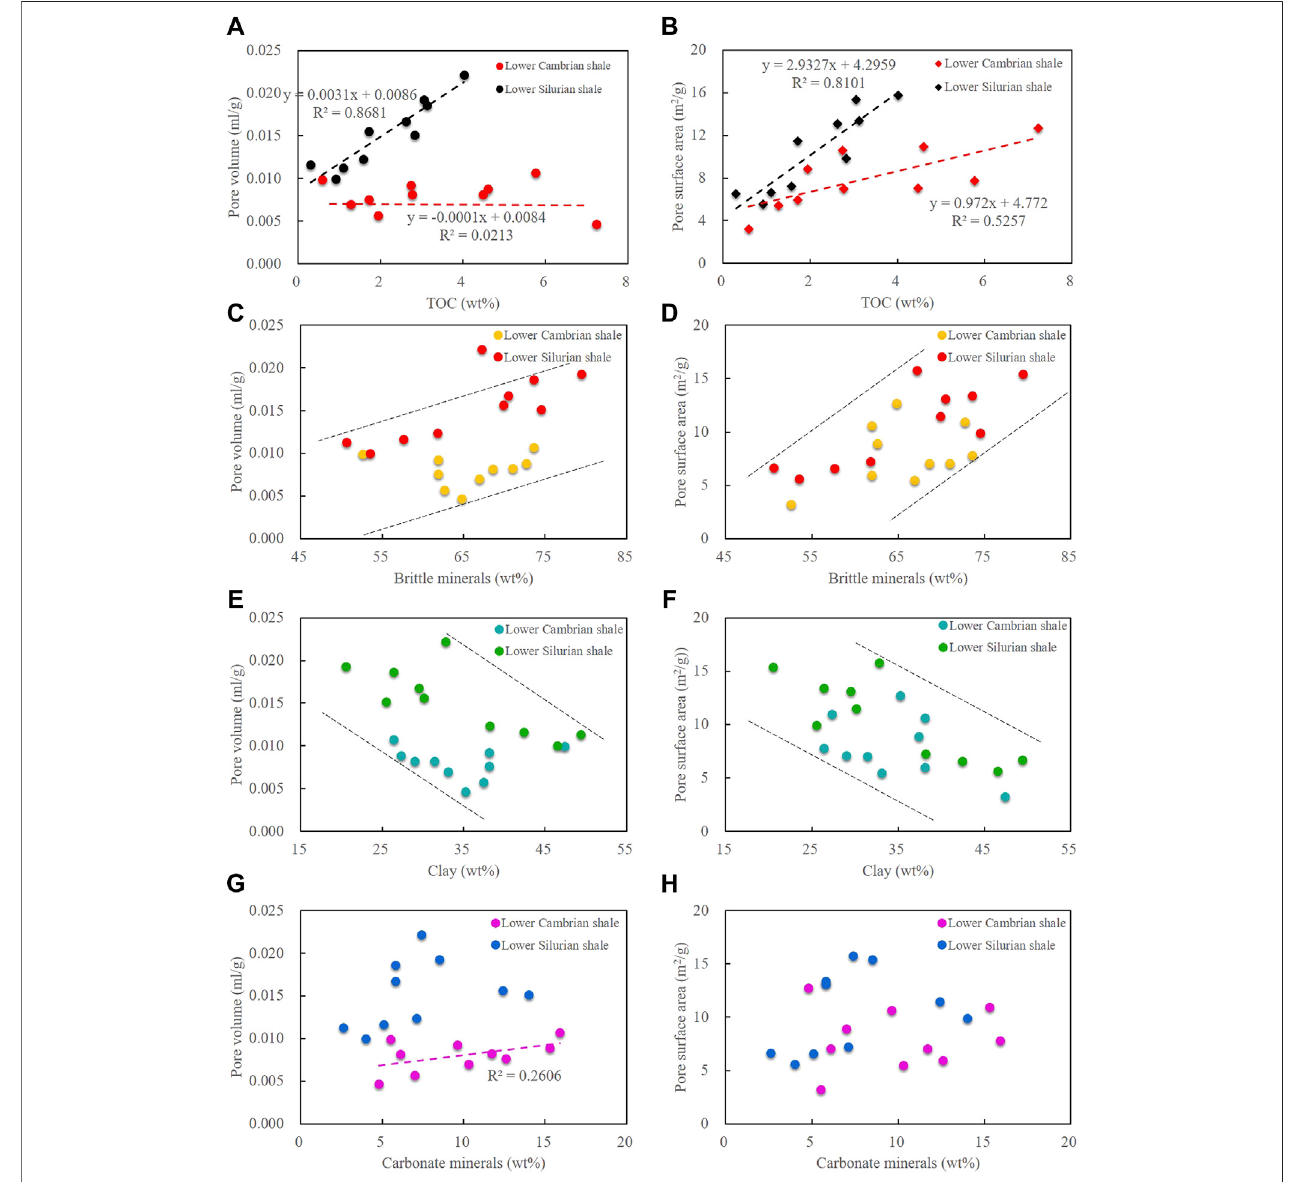
FIGURE 10 | Plots of pore volumes and pore surface areas vs. TOC (A,B) and brittle mineral content (C,D) , clay mineral content (E,F), and carbonate mineral content (G,H) .